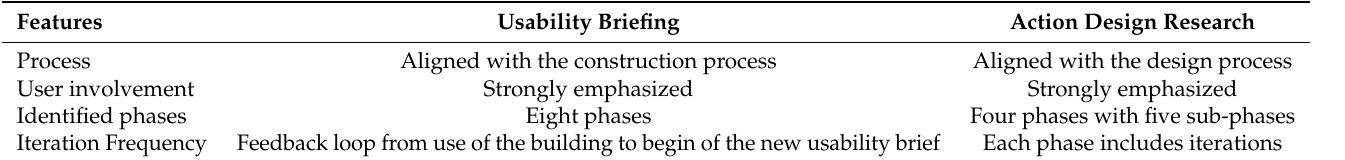
Table 1. Comparison of the process